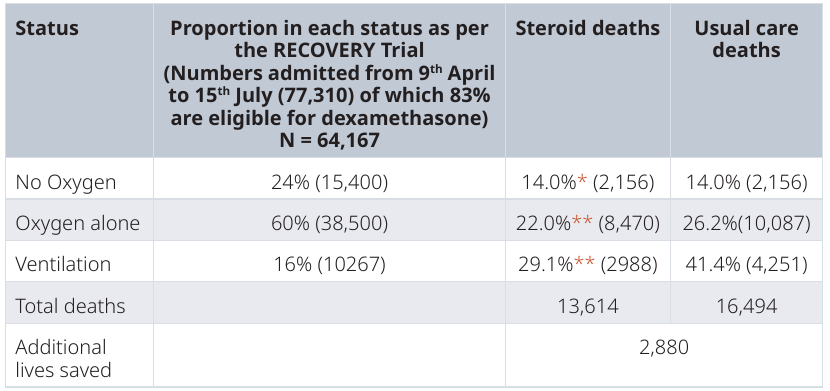
Table 2. Estimated additional patients who survived up to 15 th July with 50% recruitment to